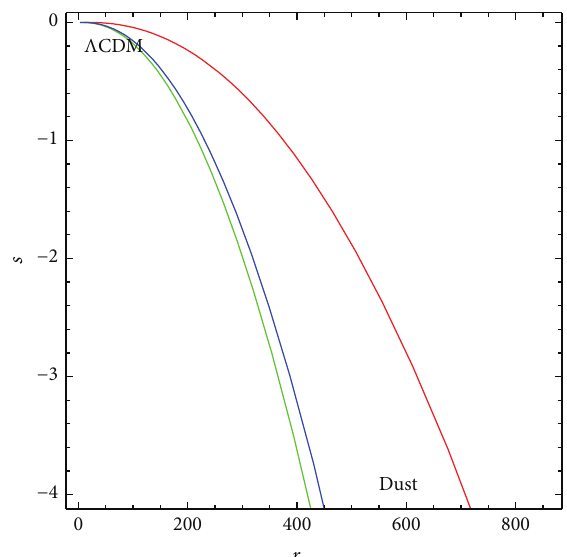
Figure 8: The {𝑟 − 𝑠} trajectory based on (36). Red, green, and blue ̇Π lines correspond to {𝛼,𝛽} combination of {0.9735, 3701} with 𝜂 = based on (31). 3.5 × 10 −4 , 3.0 × 10 −4 , and 2.5 × 10 −4 ,